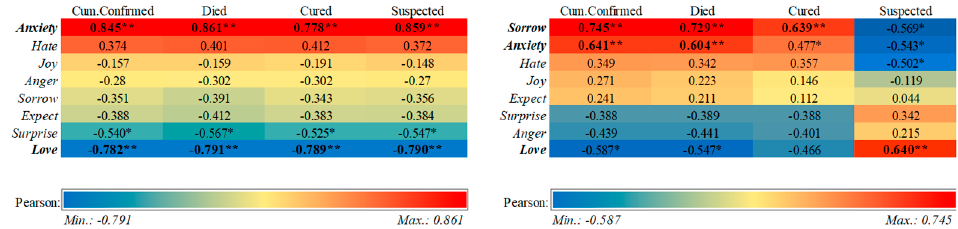
Figure 11. Heat map of correlation between the number of infected people and emotions exhibited. ** p < 0.01, * p <